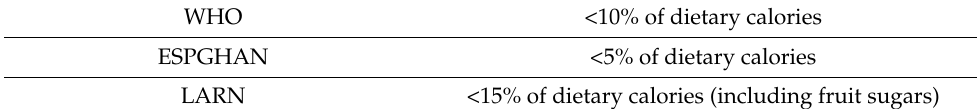
Table 2. Recommended intake of sugar in pediatric